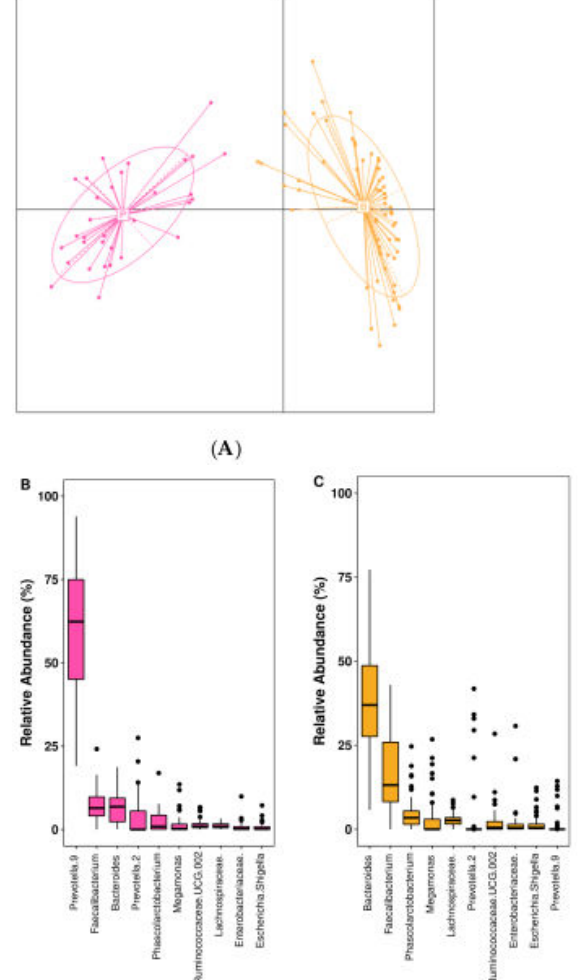
Figure 1. Gut microbiome enterotype and bacterial taxa in each enterotype: ( A ) gut microbiome profiles were separated into EnP and EnB based on the enterotyping method and were visualized by PCoA, in which X -axis and Y -axis represent the first and second principal components. Ten highest average taxonomic relative abundances at the genus level in EnP ( B ) and EnB ( C ) were demonstrated by